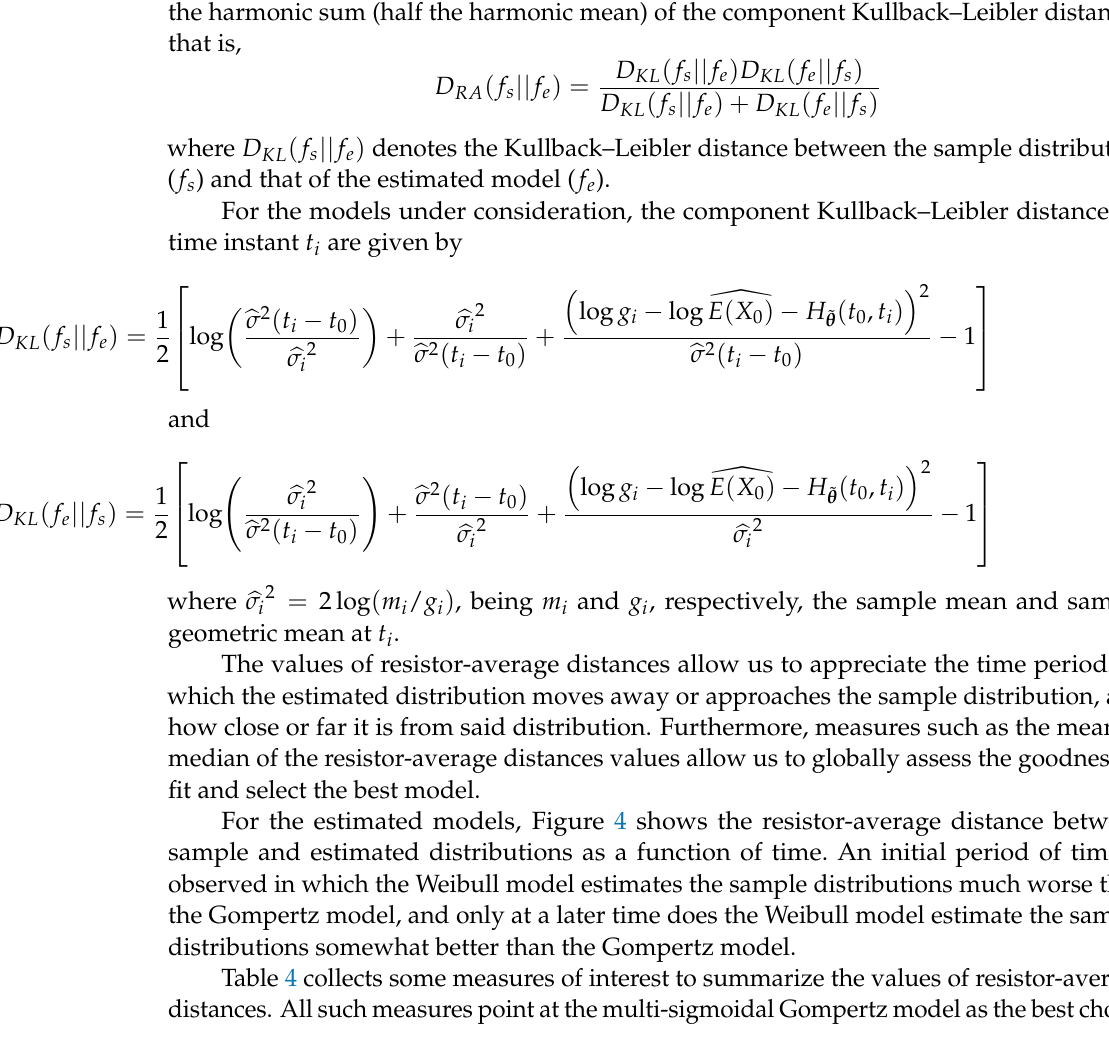
Table 4. Study of infected: Measures of interest from the values of resistor-average distances for each